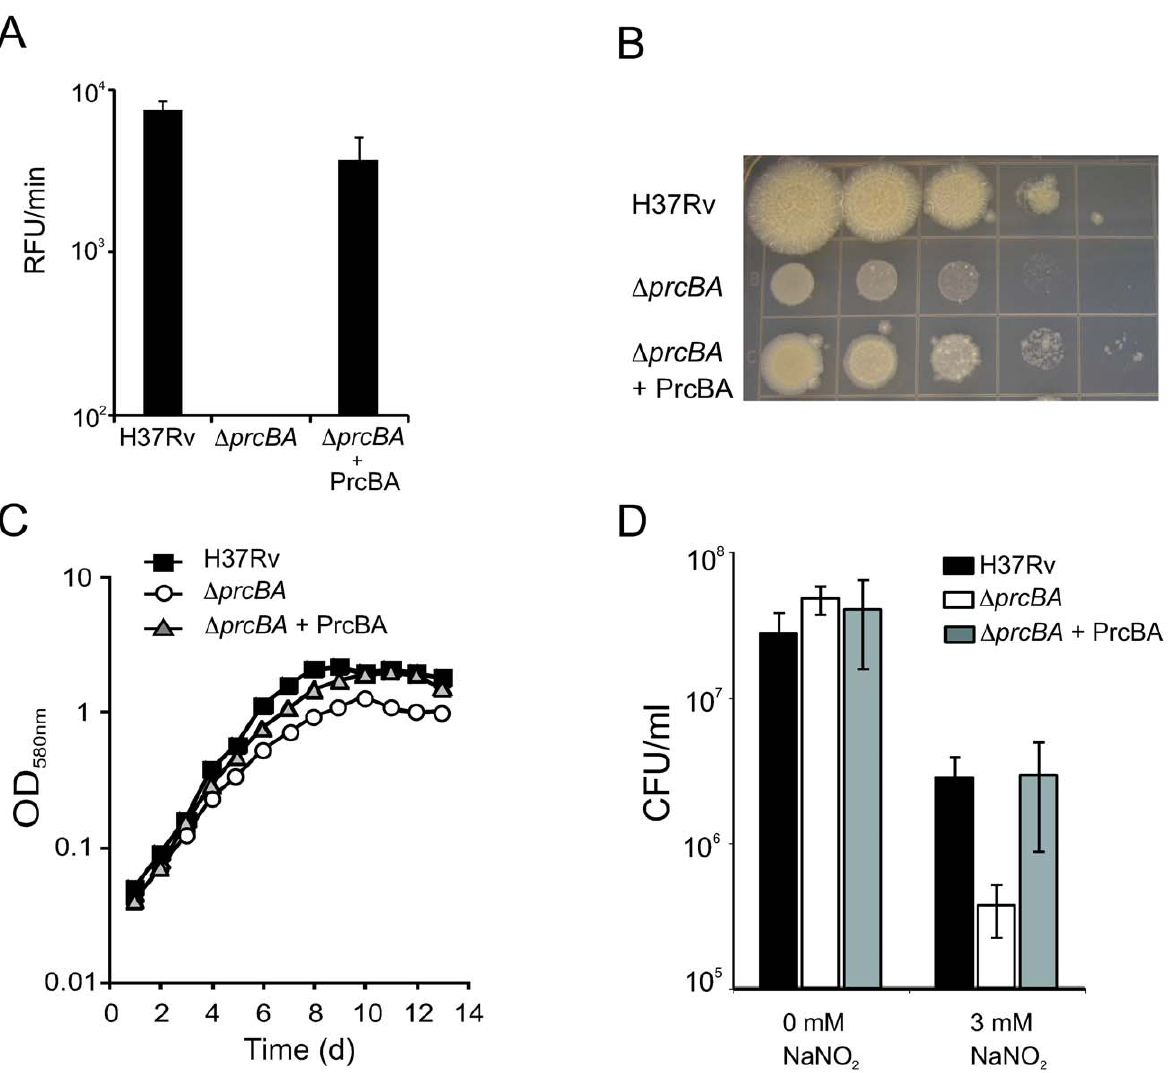
Figure 1. The proteasome is required for optimal growth invitro and for resistance to RNI. ( A ) Proteasome activities in H37Rv, D prcBA and the complemented mutant ( D prcBA + PrcBA). The cleavage velocity (RFU/min) of the fluorogenic peptide substrate Suc-LLVY-AMC reports proteasome activity. Proteasome activity was not detectable in D prcBA . Data are means 6 s.d. of three independent experiments. ( B ) Growth of H37Rv, D prcBA and D prcBA + PrcBA on agar plates. Serial dilution of the three stains were spotted onto 7H11 agar plates and incubated for 3 weeks at 37 u C. ( C ) Growth of H37Rv, D prcBA and D prcBA + PrcBA in liquid culture. Strains were inoculated in 7H9 media and growth was followed by measuring OD 580 . ( D ) Susceptibility to reactive nitrogen intermediates. Colony forming units (CFU) of H37Rv, D prcBA and the complemented strain after three days exposure to 0 mM and 3 mM sodium nitrite at pH 5.5. Data are means 6 s.d. of triplicate cultures and representative of three independent experiments.